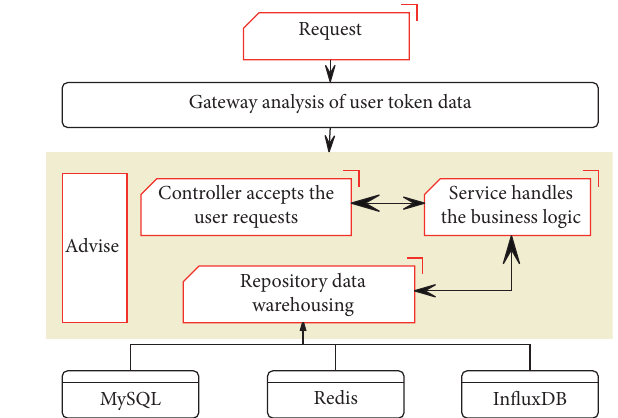
Figure 9: Server-side architecture.